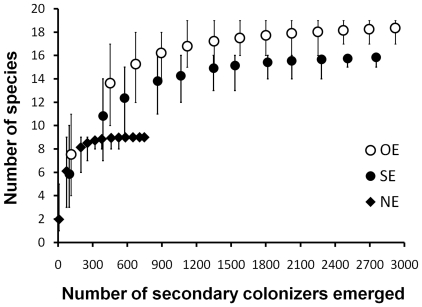
Rarefaction curves plotting the number of species of secondary
colonizers vs. the number of individuals sampled in
detached Spondias purpurea branches.NE  =  non-engineered branches; SE
 =  simulated-engineered branches; and OE
 =  O. albomarginata chamela-
engineered branches. Bars represent 95% confidence intervals
obtained from 10 000 re-sampling iterations. Bars that overlap the mean
for alternate treatments indicate that treatments were not significantly
different (P>0.05).